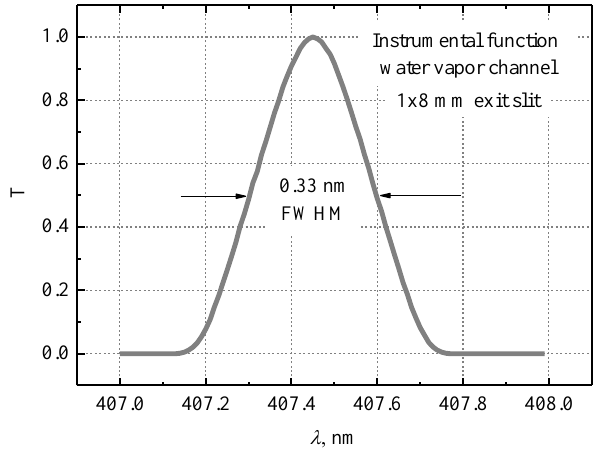
Fig. 10. Instrumental function of the water vapor channel calculated with OLSO ® for exit slit width of 1mm. The function maximum is centered at 407.45nm for minimal temperature